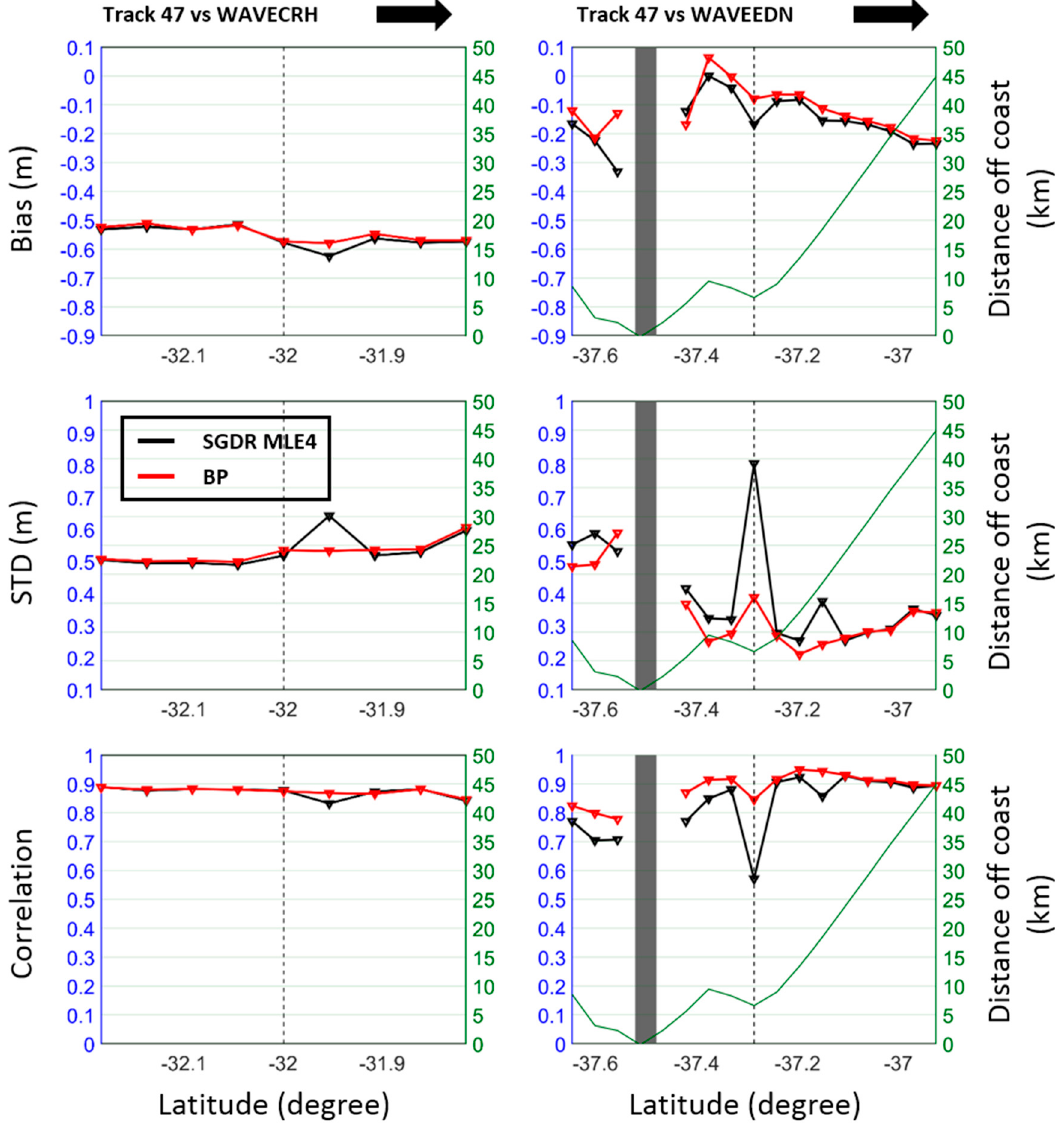
Figure 9. Similar to Figure 5, but for track 47 against buoy SWHs at WAVECRH ( left ) and WAVEEDN ( right ) in New South Wales.